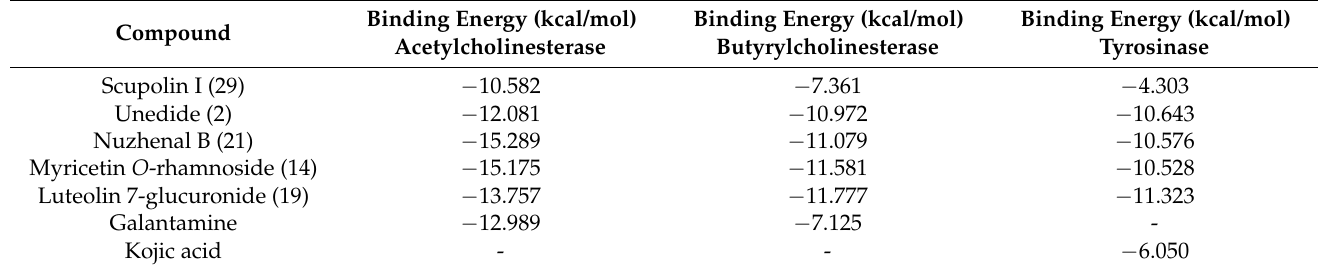
Table 4. Binding energies obtained from docking experiments of selected major compounds in Gaultheria pumila berries extract, as well as the known inhibitors galantamine and kojic acid over acetylcholinesterase ( Tc AChE), butyrylcholinesterase, ( h BChE) and tyrosinase